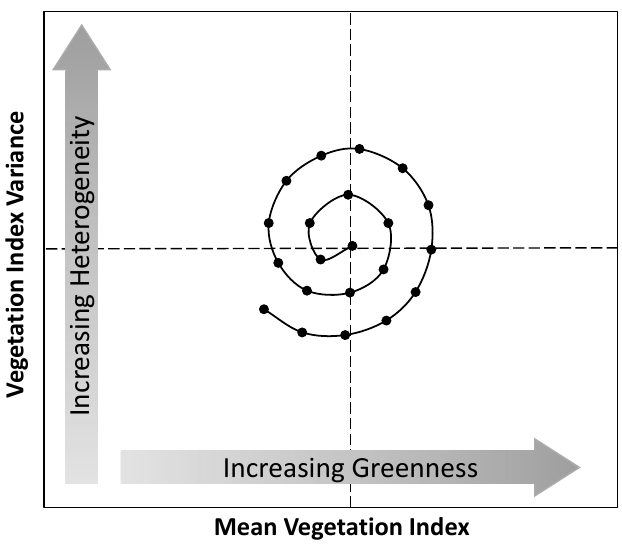
Figure 3. Relationship between mean-variance of the vegetation index and the vegetation status [26].